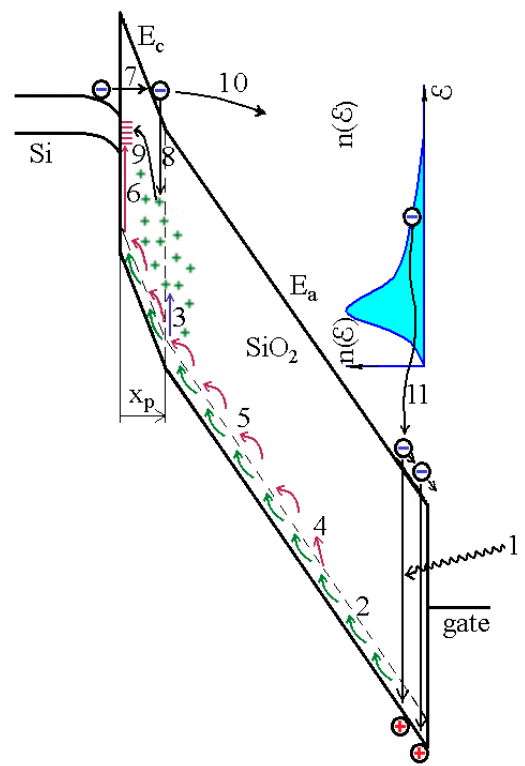
Figure 2. Band diagram of the MOS structure demonstrating main charge effects taking place under concurrent influence by radiation and high-field tunnel injection of electrons by Fowler–Nordheim: 1—creation of electron-hole pairs by radiation; 2—hole transport; 3—capturing of holes on traps in SiO 2 at its interface with silicon; 4—hydrogen liberation; 5—hydrogen transport; 6—interaction of